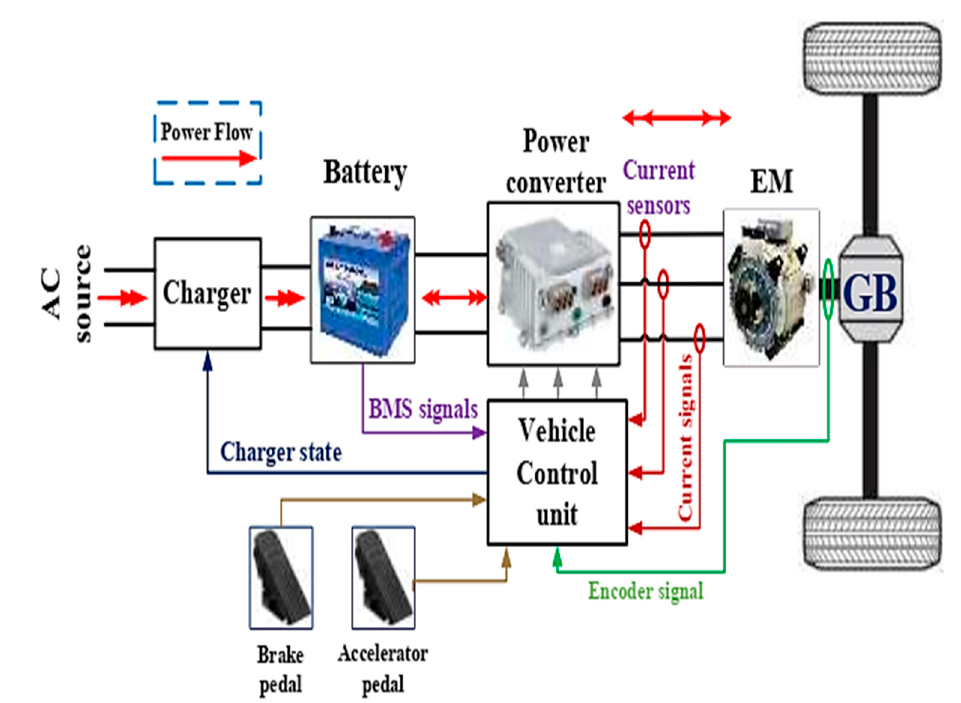
Figure 1. Simple structure of the ba tt ery and electric vehicle.